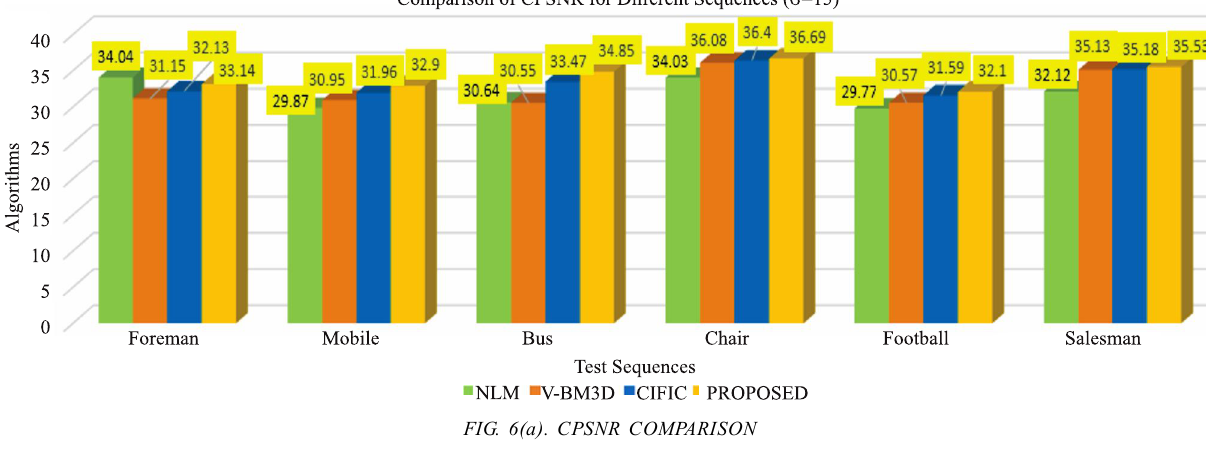
FIG. 6(a). CPSNR COMPARISON